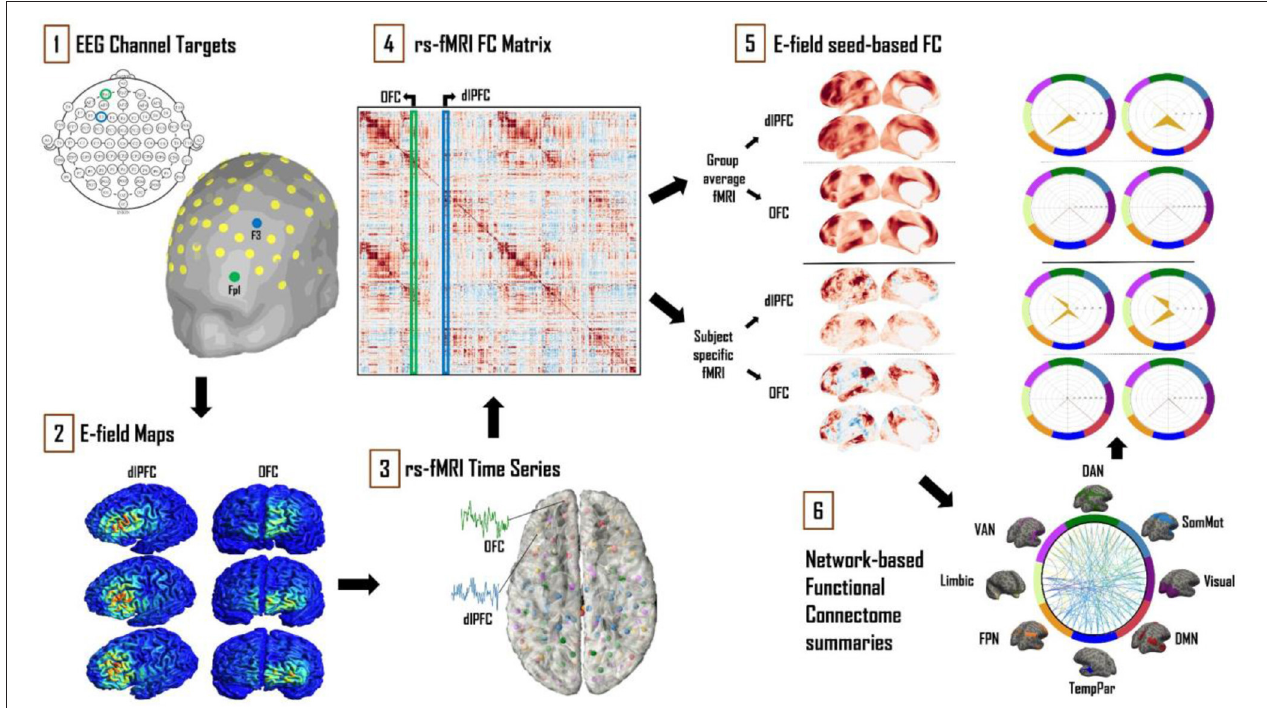
FIGURE 1 | Schematic of the analytical approach. (1) Left dlPFC and OFC 10–20 EEG electrode locations were identified as F3 and Fp1, respectively. (2) SimNIBS simulations were run using these electrode locations as TMS coil placements, with the main output of interest being cortical surface E-field maps. (3) Resting-state fMRI time series for 121 subjects from the HCP database were averaged and converted into “dense connectome” FC matrices. (4) The connectivity patterns of each subject’s E-field were determined using these dense connectomes. (5) FC maps of the resulting E-fields were thus obtained with group-averaged and subject-specific resting-state fMRI data. (6) These maps were further analyzed and summarized in terms of connectivity to the canonical multi-network parcellation templates of Leo et al. (23). The most prominent networks targeted by dlPFC and OFC TMS are reported. Spider plot visualizations in this example and later figures show the networks being targeted as a percentage (area of the orange polygon) of the suprathreshold E-field